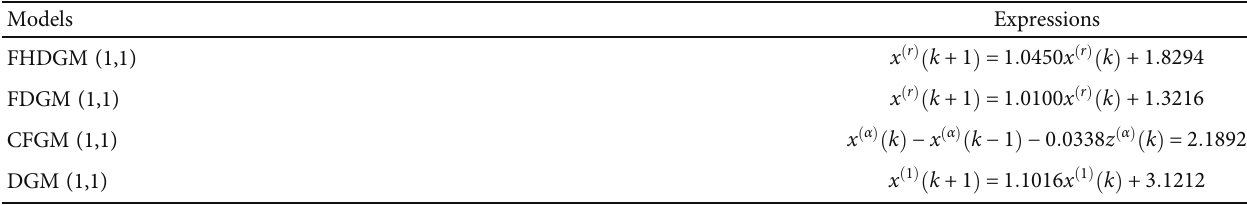
Table 10: The expression of four grey models.